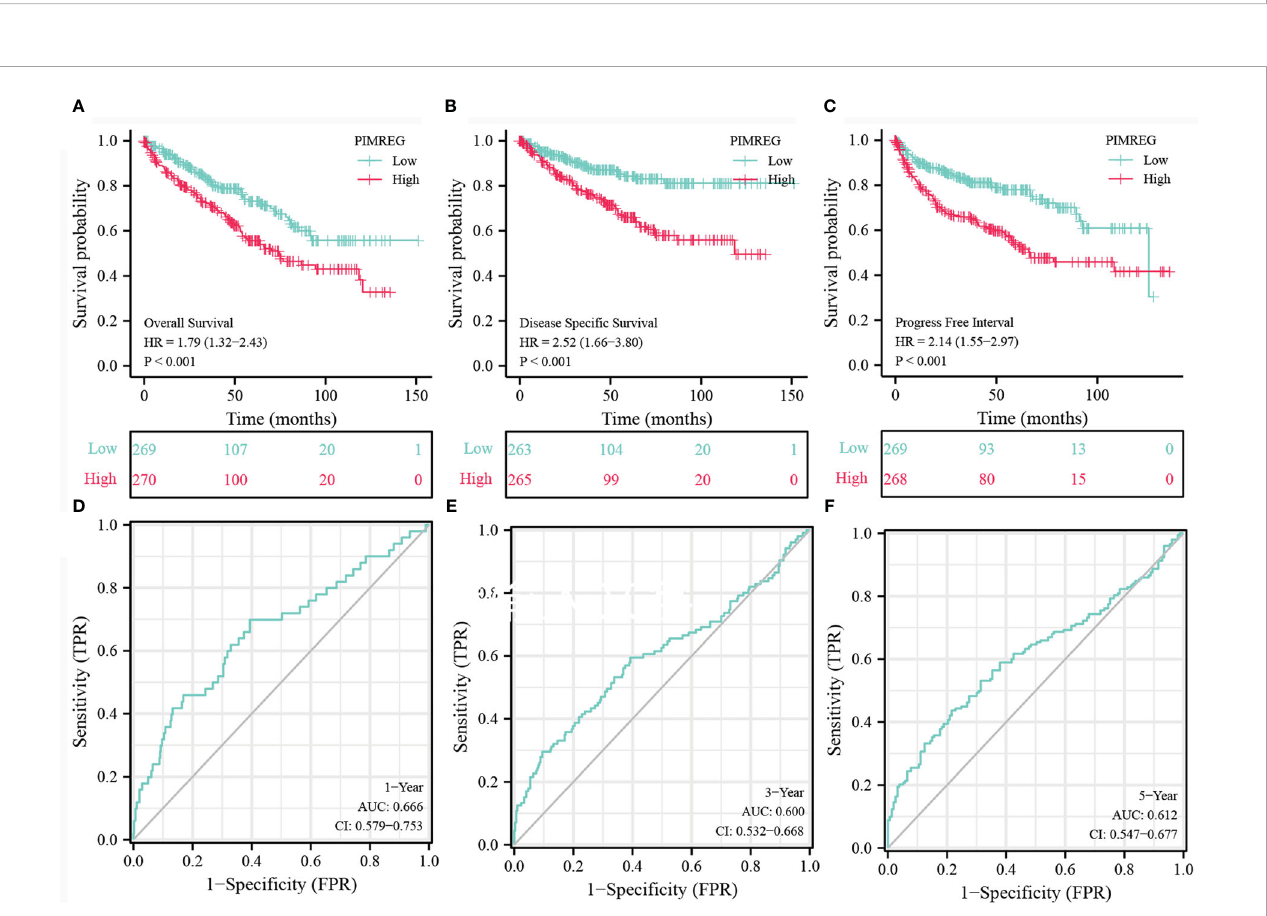
FIGURE 3 Analysis about Kaplan-Meier and ROC curves for PIMREG . (A-C) Kaplan-Meier survival curves indicated that ccRCC patients with high PIMREG mRNA expression had a shorter OS, DSS and DFI than the low PIMREG mRNA expression group. (D-F) ROC curve predicted the accuracy of OS in 1-, 3-, 5- years. ccRCC, clear cell renal cell carcinoma; OS, overall survival; DSS, disease speci fi c survival; PFI, progression-free interval.